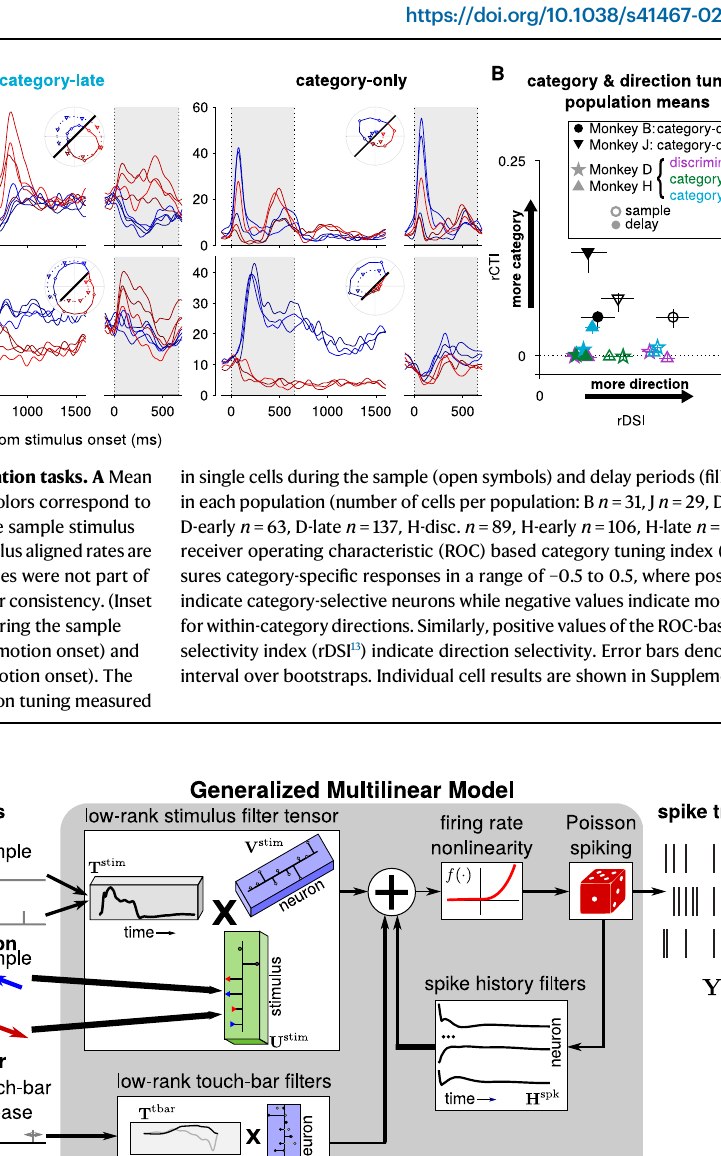
categoryinformation(left;SupplementaryFig. 3E – I).Asetof temporalkernelsand